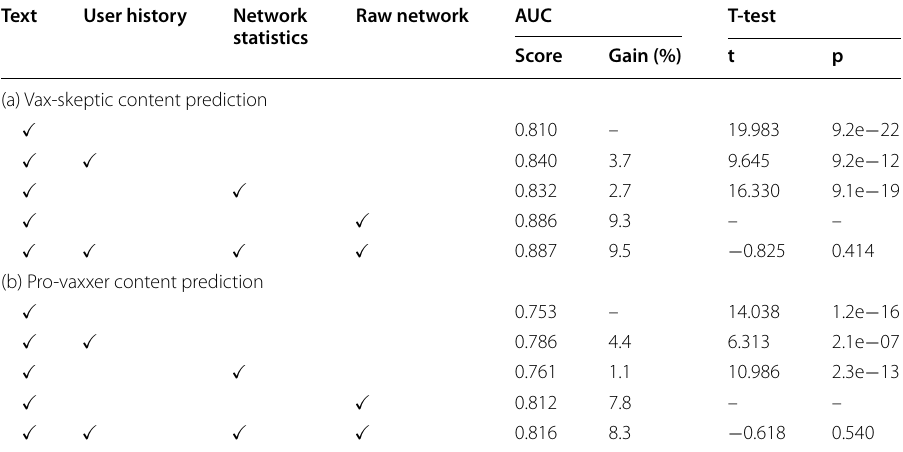
The performance gain is shown over classification based on text only. Here, raw network represents Walklets (Perozzi et al. 2016), the best-performing node embedding model as seen in Fig. 11. Columns on the right report results of T-tests against text raw network using 20 independent training-testing samples +